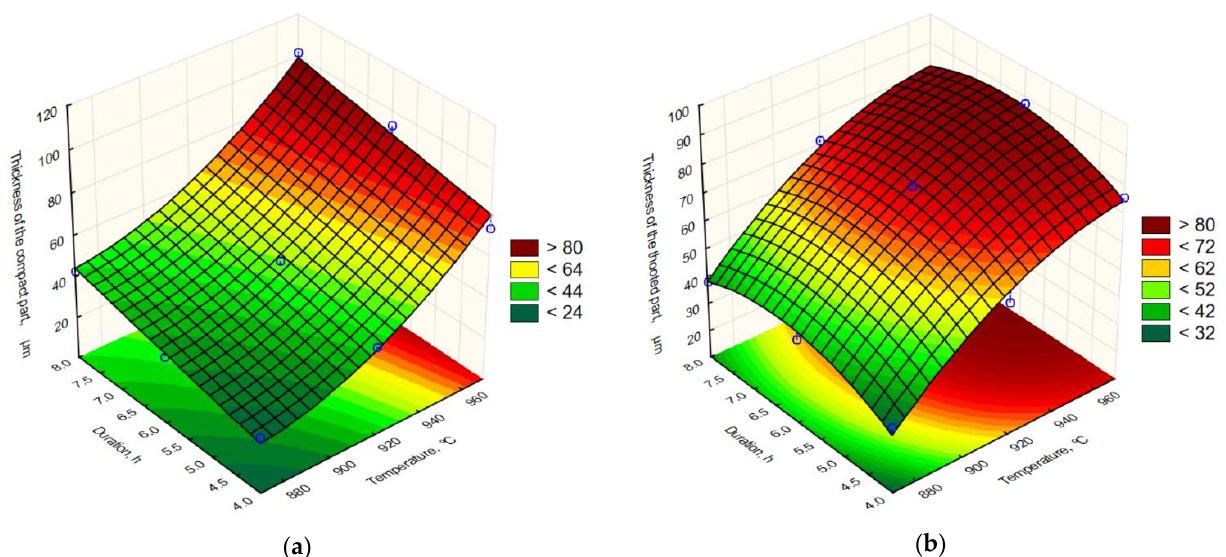
Figure 8. Response surface of regression equation for ( a ) the thickness of the compact part of boride layer; ( b ) the thickness of the toothed part of boride